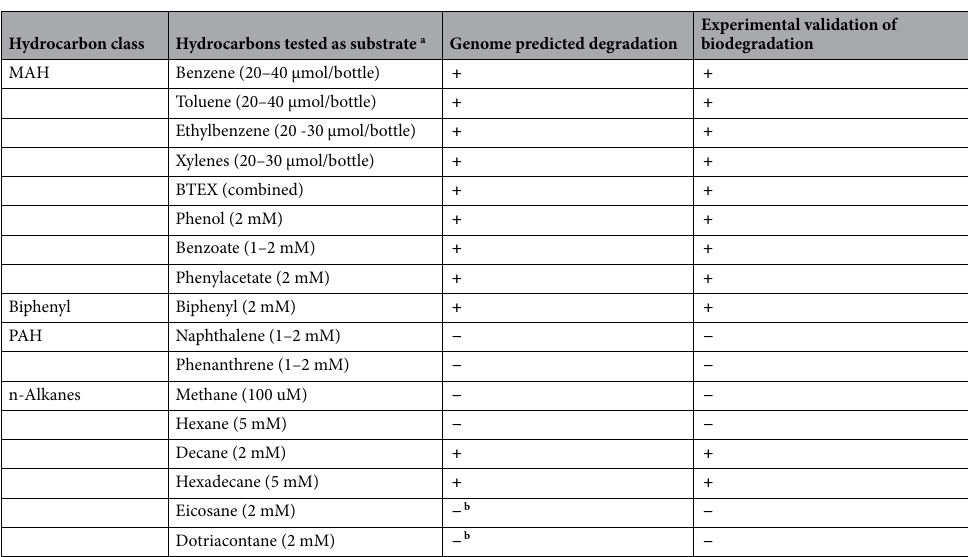
Table 3. Laboratory assessment of the biodegradation ability of strain Wilcox. Strain Wilcox grown in mineral salts medium supplemented with 2.5 M NaCl and amended with a hydrocarbon as the sole source of carbon and energy were used to study the degradation potential of strain Wilcox. Cultures were inoculated with approximately 5 × 10 5 or 1.2 × 10 6 CFU of strain Wilcox. a BTEX compounds and methane were determined using a gas chromatograph 40,41 . Degradation activities on biphenyl, phenol, phenylacetate, n-hexane, n-decane, n-hexadecane, n-eicosane, and n-dotriacontane were determined as CFU. Benzoate degradation was monitored using absorption at 223 λ using a spectrometer. b We did not identify homologs of almA or ladA genes known to act on longer-chain alkanes. ( +) Degraded as the sole carbon and energy source. ( −) No growth or degradation. The data points are averages of triplicate bottles.